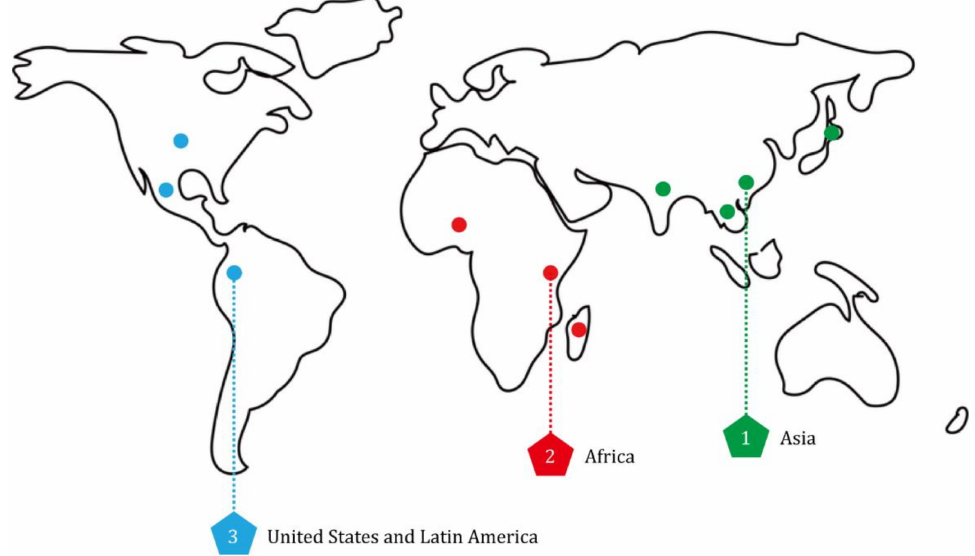
Figure 1. Global distribution of rice viral diseases. Three rice viral disease endemic areas are illustrated by circles with different colors. Green circles represent the main areas of rice viral diseases in Asia. Red circles represent the main areas of rice viral diseases in Africa. Blue circles represent the main areas of rice viral diseases in the United States and Latin America. Table 1. Known rice viruses in rice-growing areas